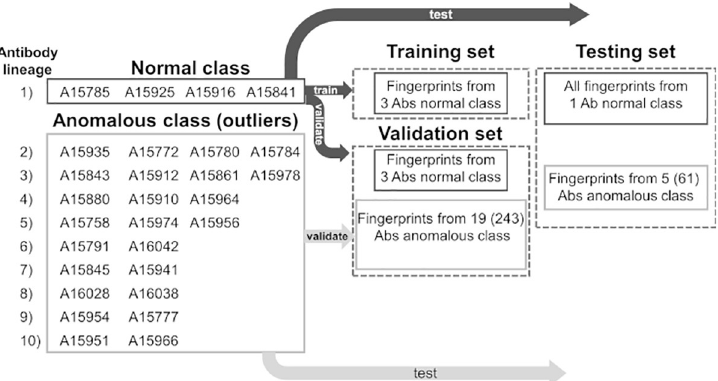
Fig 14. Schematic diagram of the allocation of Ab fingerprints into training, validation, and testing sets for one- class classification. See text for an explanation of antibody and fingerprints assignment. Note : the Abs labels have been simplified where “A” stands for